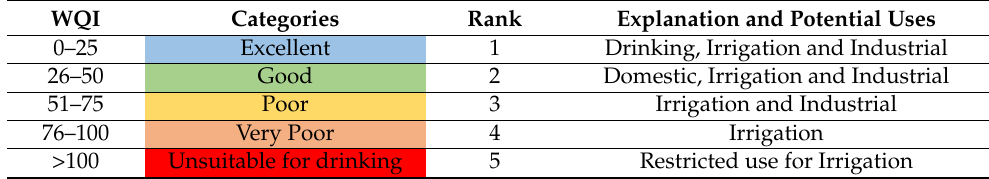
Table 2. Classification of water quality based on WQI values